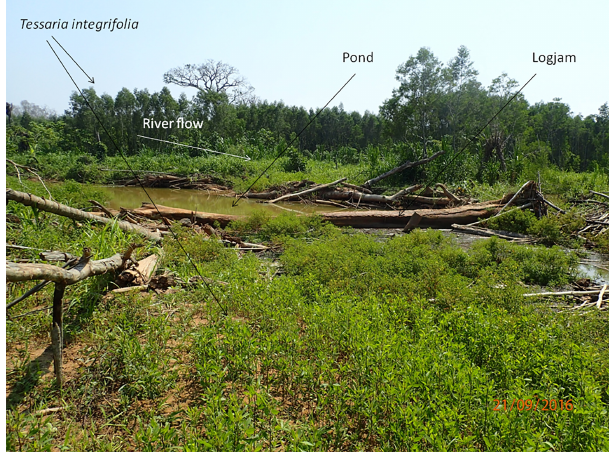
Figure 9. Logjam formed in 2016 in the Colorado River. The log- jam spans the entire channel and has low